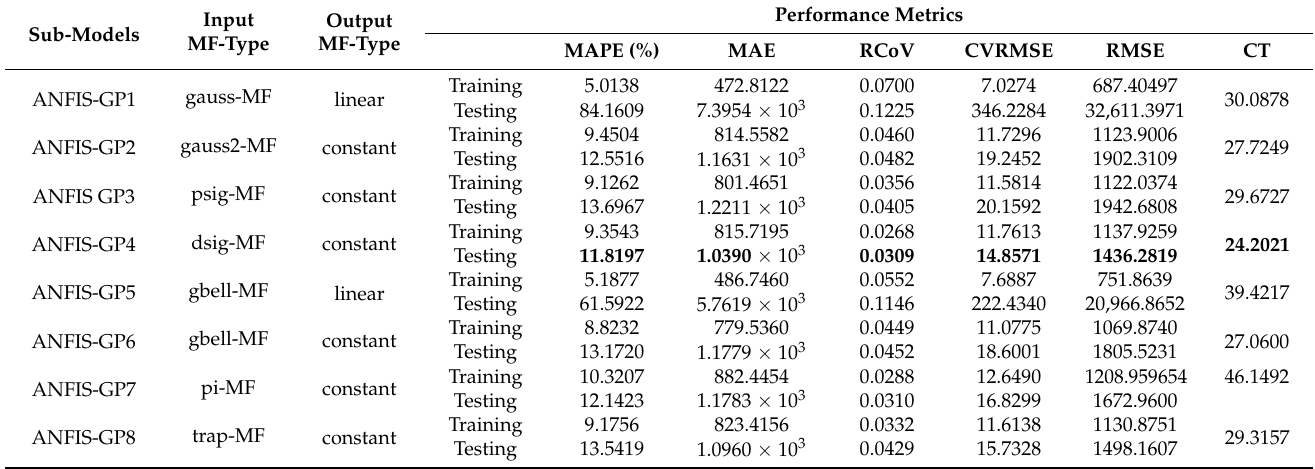
Table 4. Performance analysis for ANFIS-GP models.